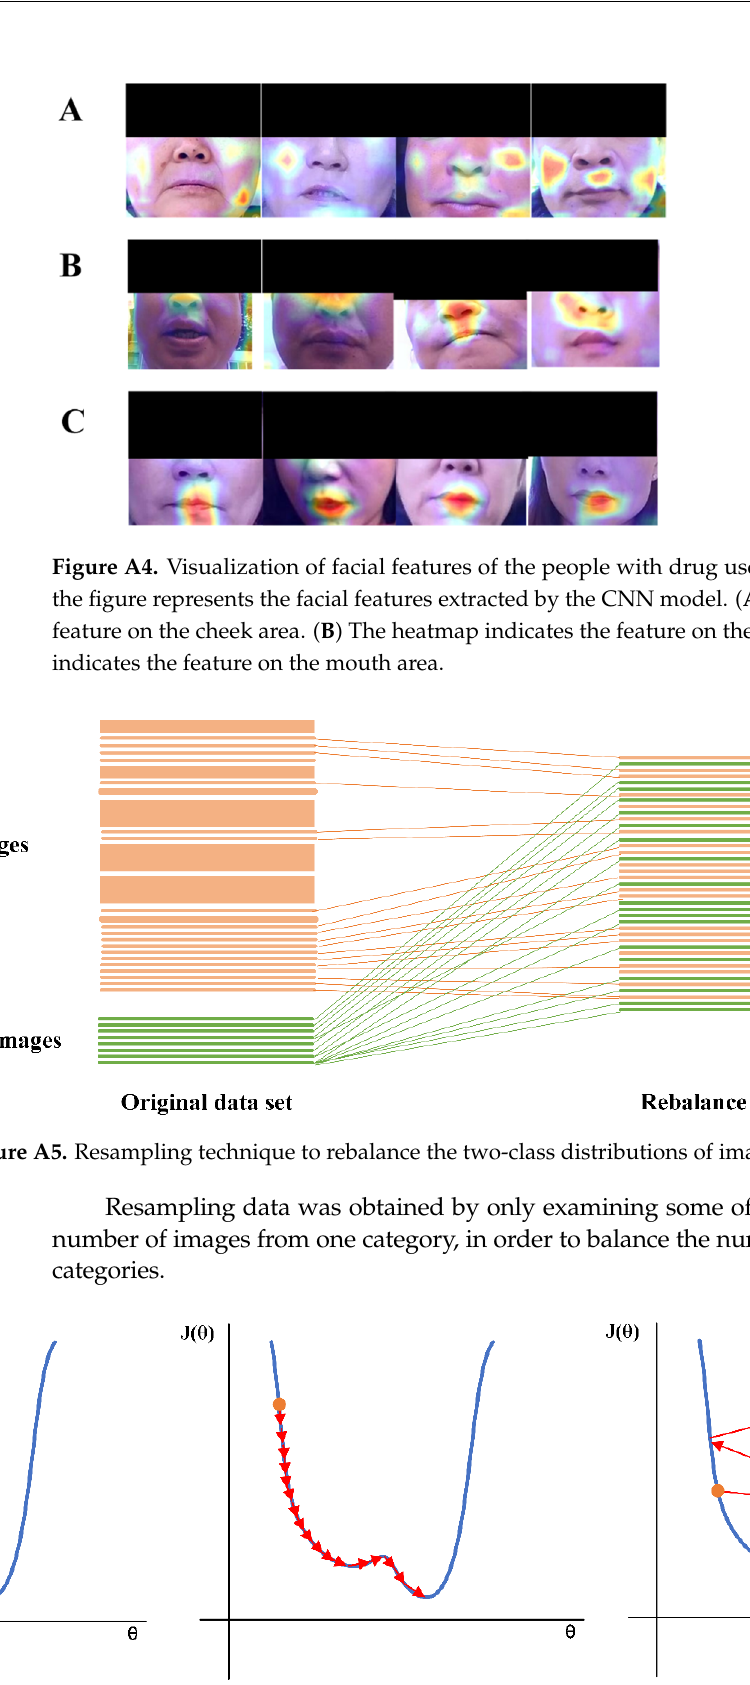
Figure B3. The results of sensitivity and specificity of the seven external validation datasets.